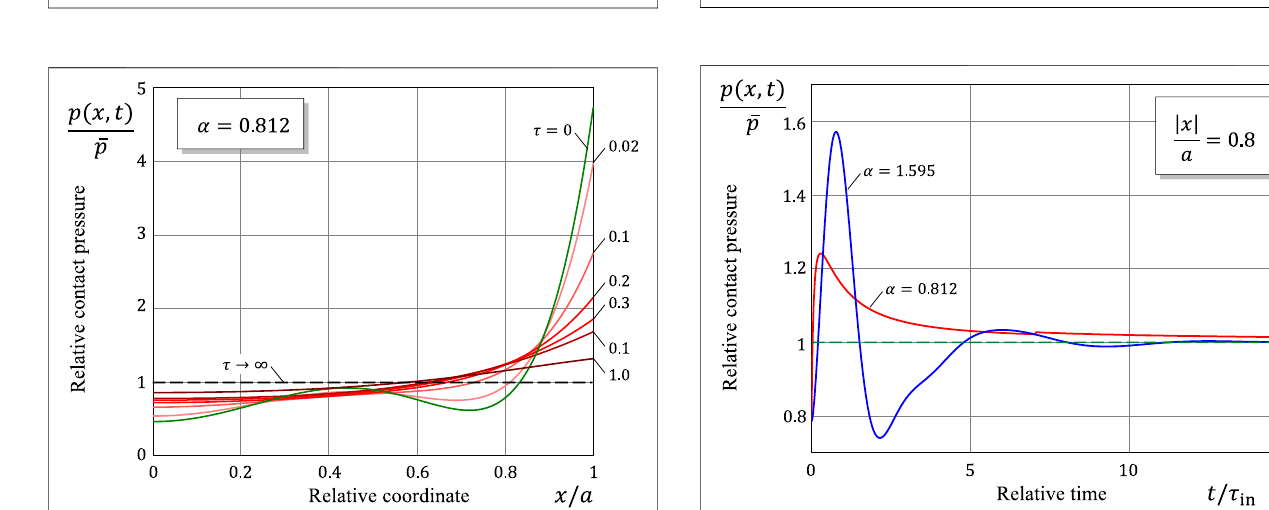
FIGURE 5 | Time-variation of the contact pressure at the center of the contact zone.